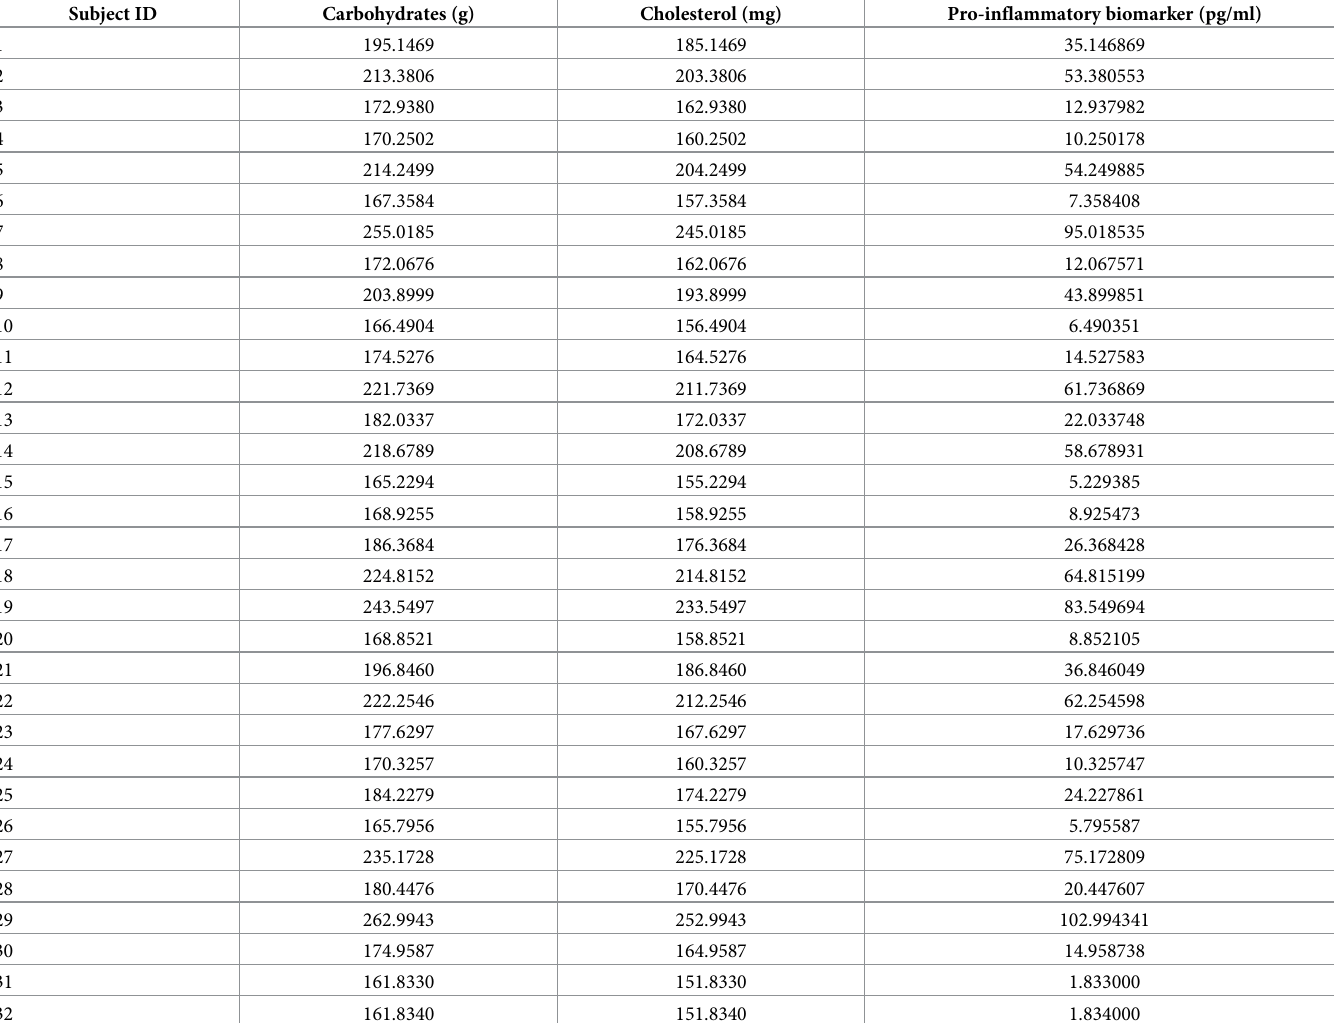
Table 1. Simulated data on daily consumption of food parameters and on a pro-inflammatory biomarker used for the Dietary Inflammatory Index (DII) calculation and analyses �